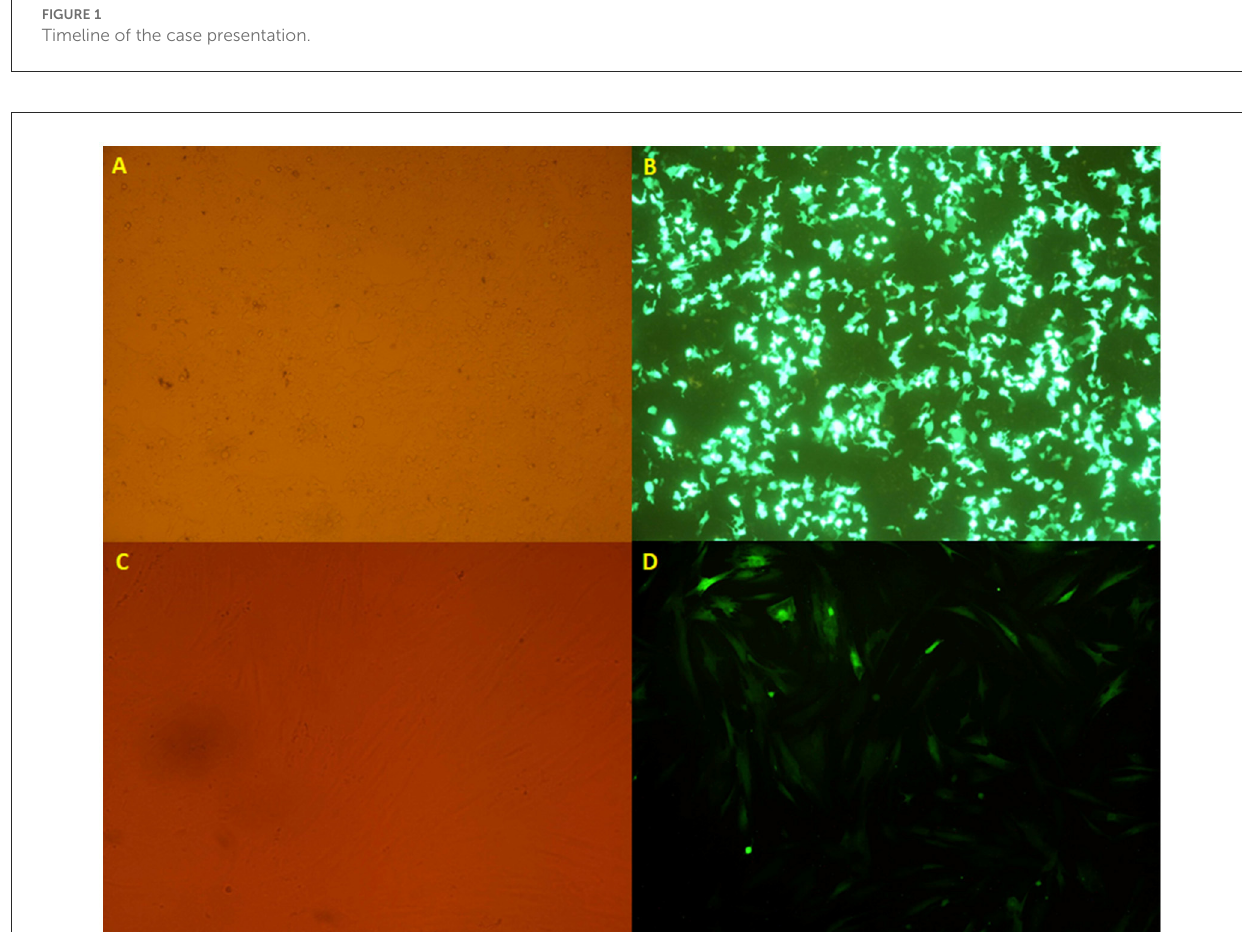
FIGURE2 (A, B) The HEK 293T cell lines transfected with the calcium phosphate method, taken from an inverted microscope (10 × ), which shows (A) visible light and (B) fluorescent light. (C, D) The transduced mesenchymal stem cells originated from an inverted microscope (10 × ), which indicates (C) visible light and (D) fluorescent